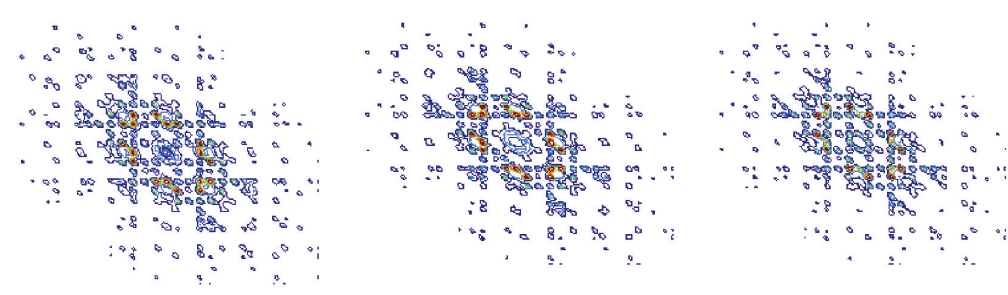
Figure 8: Bispectrum contour map of normal condition.